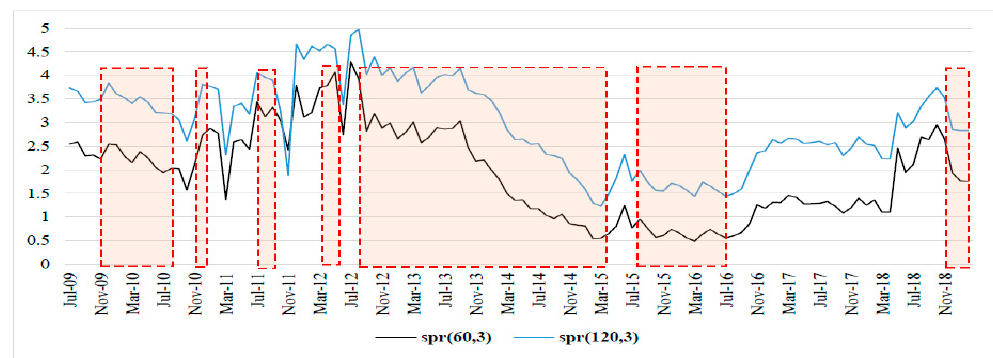
Figure 4. Yield spread-Italy.